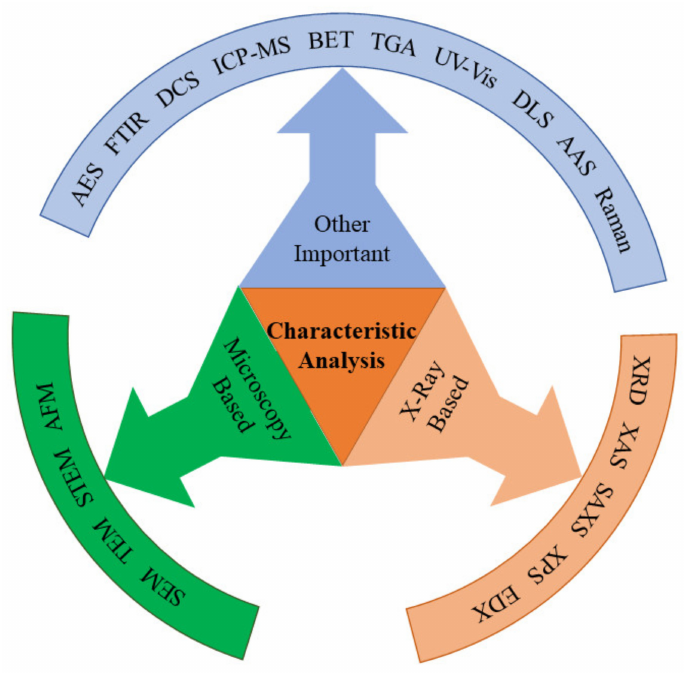
Figure 10. Characterization tools for nanomaterial characterization. Table 3. Summary and comparison of different characterization